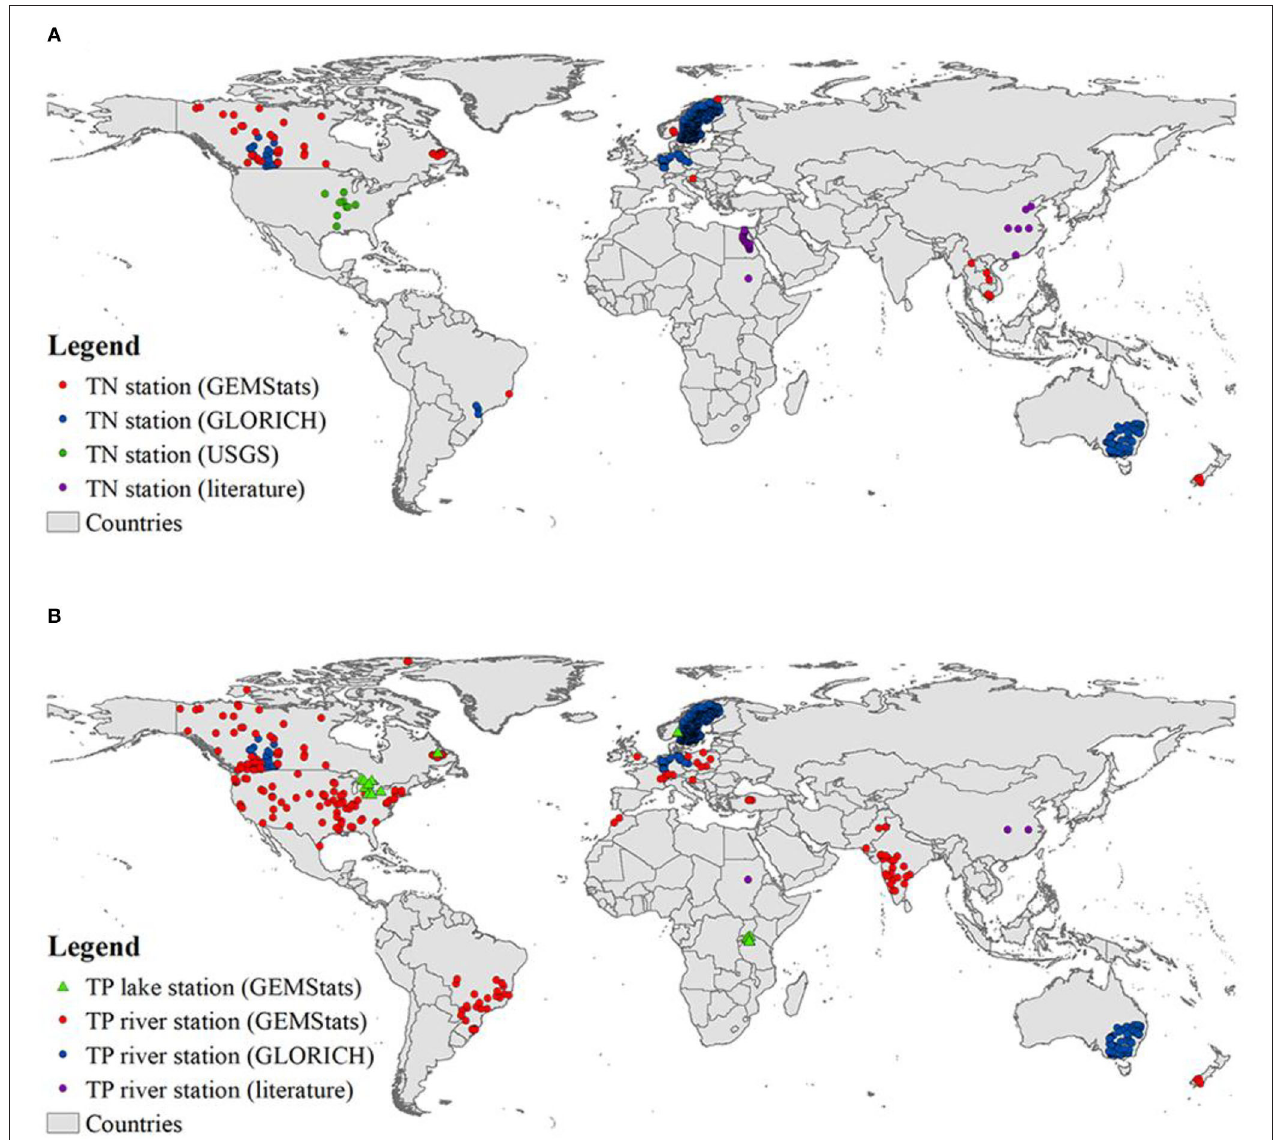
FIGURE 1 | Sampling stations of (A) TN and (B) TP concentration over the globe. For N, all the stations are river stations. Note that (1) due to a lack of TN observations in global lakes, lake TN was not assessed in this study; (2) for TP, GEMStats has included USGS data. (3) in total, there are 1,157 TN river stations including 63, 823, 261, and 10 stations distributed in North Frigid Zone, North Temperate Zone, South Temperate Zone, and Torrid Zone, respectively; for TP, the respective geographical zone contains 68, 1,535, 493, and 89 river stations (2,185 TP river stations